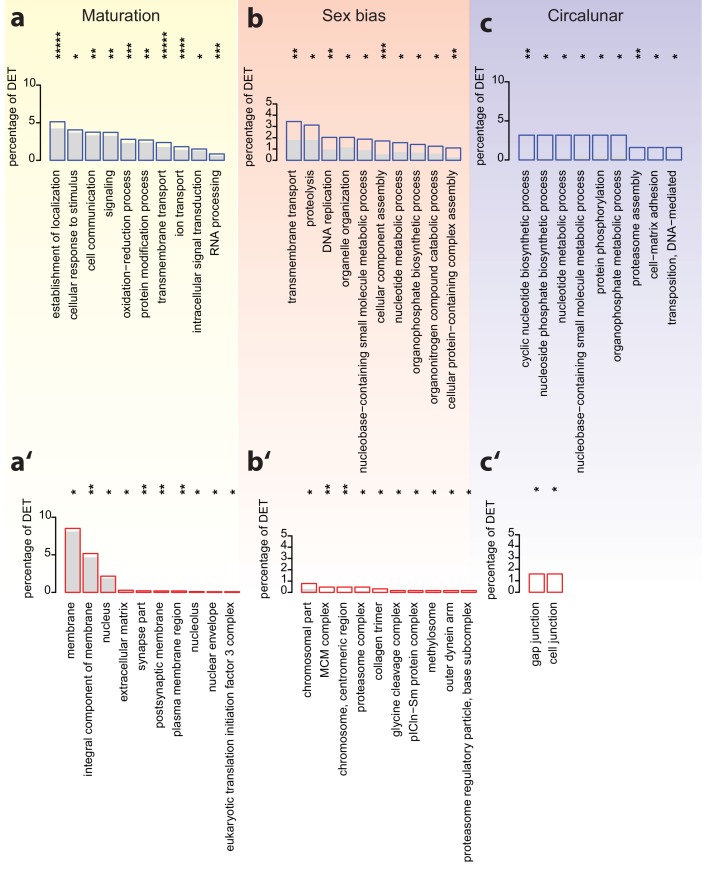
Analyses of over-represented GO-terms support the existence of distinct molecular signatures for maturation, sex and circalunar clock phase.(a–c) top 10 enriched terms in the Biological Process category; blue boxes: percentage of differentially expressed transcripts for each term; the grey bars: expected numbers of transcripts per category. Maturation: establishment of localization: GO:0051234, cellular response to stimulus: GO:0051716, cell communication: GO:0007154, signaling: GO:0023052, oxidation-reduction process: GO:0055114, protein modification process: GO:0036211, transmembrane transport: GO:0055085, ion transport: GO:0006811, intracellular signal transduction: GO:0035556, RNA processing: GO:0006396. Sex bias: transmembrane transport: GO:0055085, proteolysis: GO:0006508, DNA replication: GO:0006260, organelle organization: GO:0006996, nucleobase-containing small molecule metabolic process: GO:0055086, cellular component assembly: GO:0022607, nucleotide metabolic process: GO:0009117, organophosphate biosynthetic process: GO:0090407, organonitrogen compound catabolic process: GO:1901565, cellular protein-containing complex assembly: GO:0034622. Circalunar phase: cyclic nucleotide biosynthetic process: GO:0009190, nucleoside phosphate biosynthetic process: GO:1901293, nucleotide metabolic process, GO:0009117, nucleobase-containing small molecule metabolic process, GO:0055086, protein phosphorylation, GO:0006468, organophosphate metabolic process, GO:0019637, proteasome assembly, GO:0043248, cell-matrix adhesion, GO:0007160, transposition, DNA-mediated: GO:0006313. (a’–c’) In analogy to (a–c), these panels list the top 10 enriched terms in the Cellular Compartment category. Red boxes: percentage of differentially expressed transcripts for each term; the grey bars: expected values of transcripts per category. Maturation: membrane: GO:0016020, integral component of membrane: GO:0016021, nucleus: GO:0005634, extracellular matrix: GO:0031012, synapse part: GO:0044456, postsynaptic membrane: GO:0045211, plasma membrane region: GO:0098590, nucleolus: GO:0005730, nuclear envelope: GO:0005635, eukaryotic translation initiation factor three complex: GO:0005852. Sex bias: chromosomal part: GO:0044427, MCM complex: GO:0042555, chromosome, centromeric region: GO:0000775, proteasome complex: GO:0000502, collagen trimer: GO:0005581, glycine cleavage complex: GO:0005960, pICln-Sm protein complex: GO:0034715, methylosome: GO:0034709, outer dynein arm: GO:0036157, proteasome regulatory particle, base subcomplex: GO:0008540. Circalunar phase: gap junction: GO:0005921, cell junction: GO:0030054. For all analyses, statistical significance was tested with a hypergeometric test implemented in the GOStats package. *p < 0.05, **p < 0.01, ***p < 0.001, ****p < 0.0001, *****p < 0.00001.